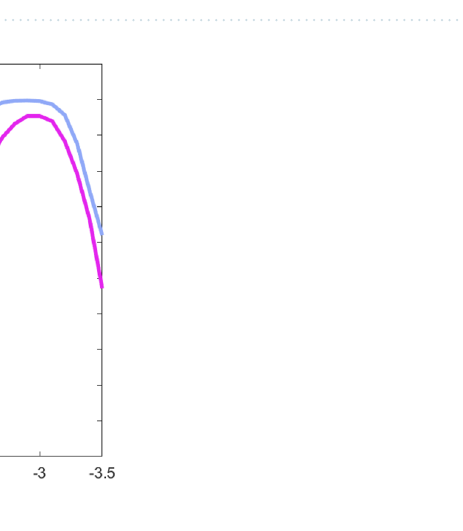
Figure 2. AMTFs of PDCI (magenta) and RCI (blue) for 3.0 mm ( a ), and 4.5 mm pupil ( b ). Dotted lines correspond to the AMTFs with the optical inlays decentered 1.0 mm with respect to the pupil center as shown in the phase maps shown with the corresponding color frames in ( c ) for 3.0 mm and ( d ) for 4.5 mm pupil diameters.